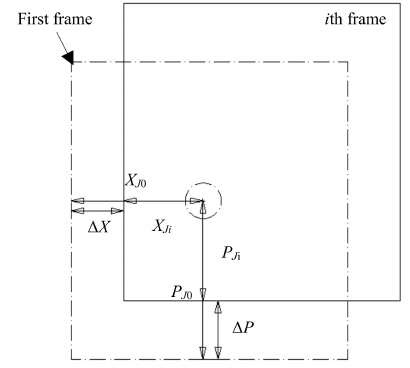
Figure 8. Offset correction.